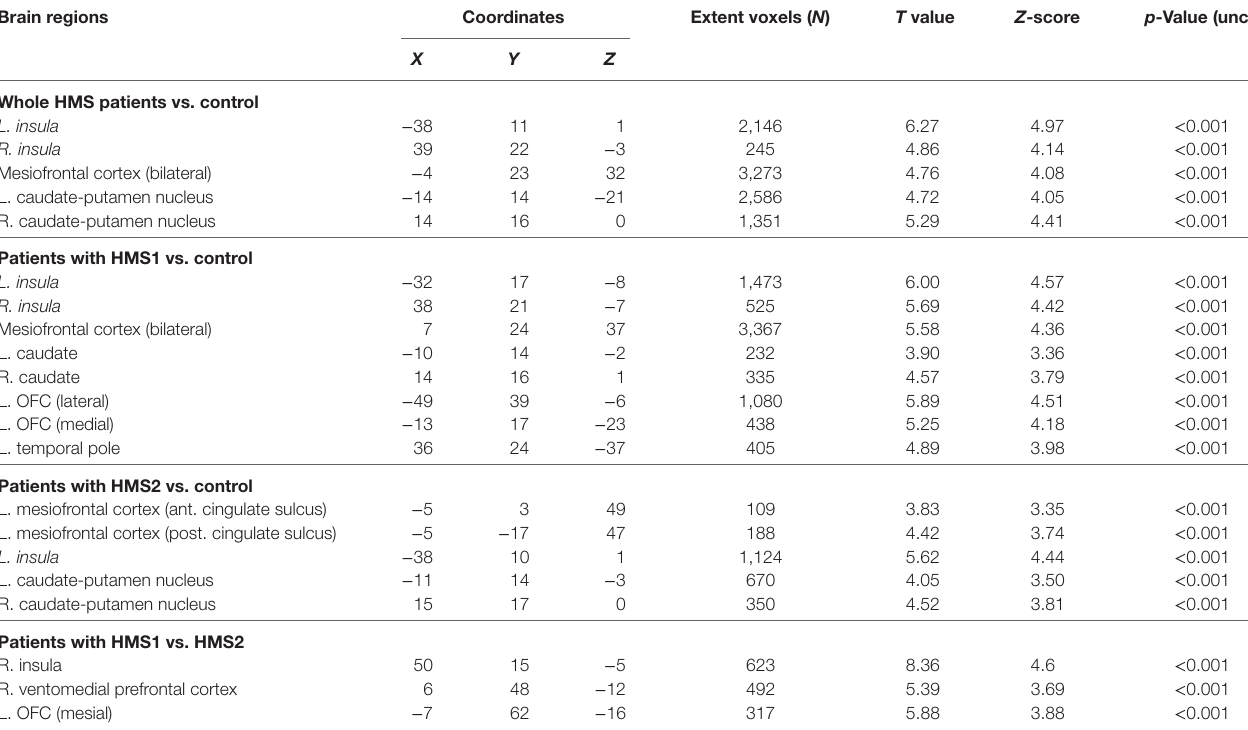
Table 3 | Brain regions with significant hypometabolism in PET analysis. brain regions coordinates extent voxels ( N ) T value Z -score p -Value (unc.) X